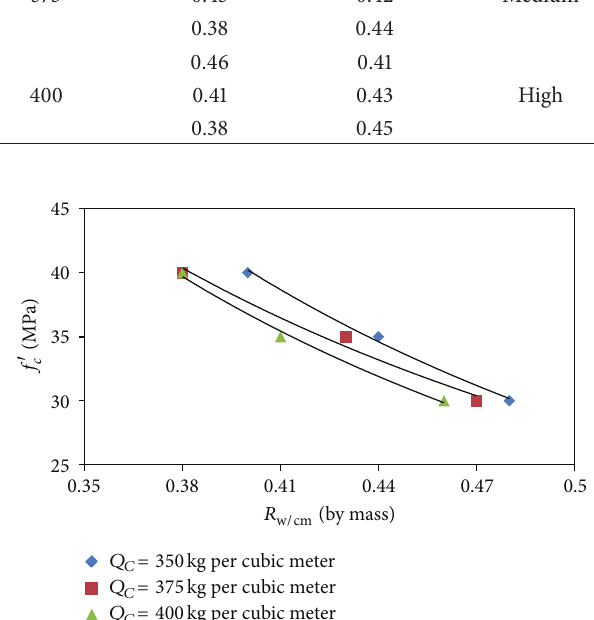
at different w / cm